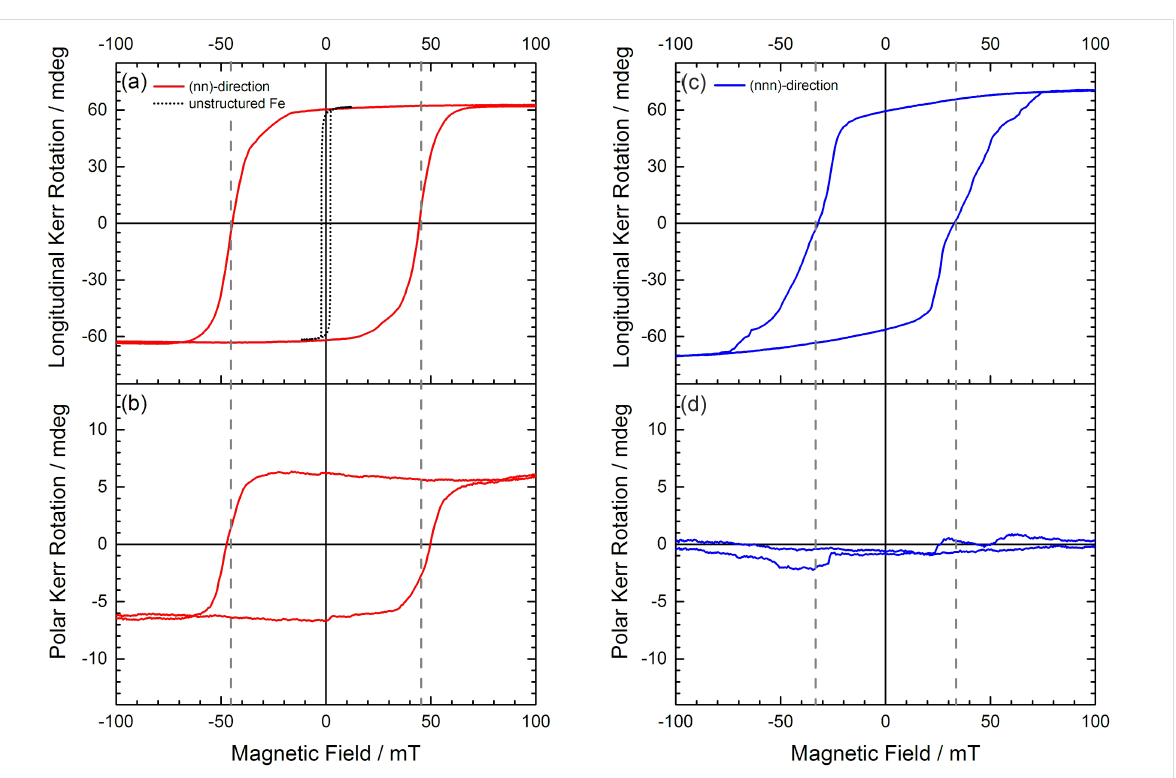
Figure 10: (a) Longitudinal and (b) polar Kerr hysteresis loops with an in-plane magnetic field applied along the nn-direction of a hexagonal antidot lattice with a = 200 nm antidot periodicity and d = 100 nm antidot diameter in a t = 20 nm thick Fe film. For comparison, the hysteresis loop of the unstructured film is additionally shown as dotted curve in (a). Panels (c) and (d) present the longitudinal and polar Kerr hysteresis loops with an in-plane magnetic field applied along the nnn-direction, respectively. The right panel has been reproduced with permission from [57] under CC-BY 3.0 license, copyright 2015 IOP Publishing